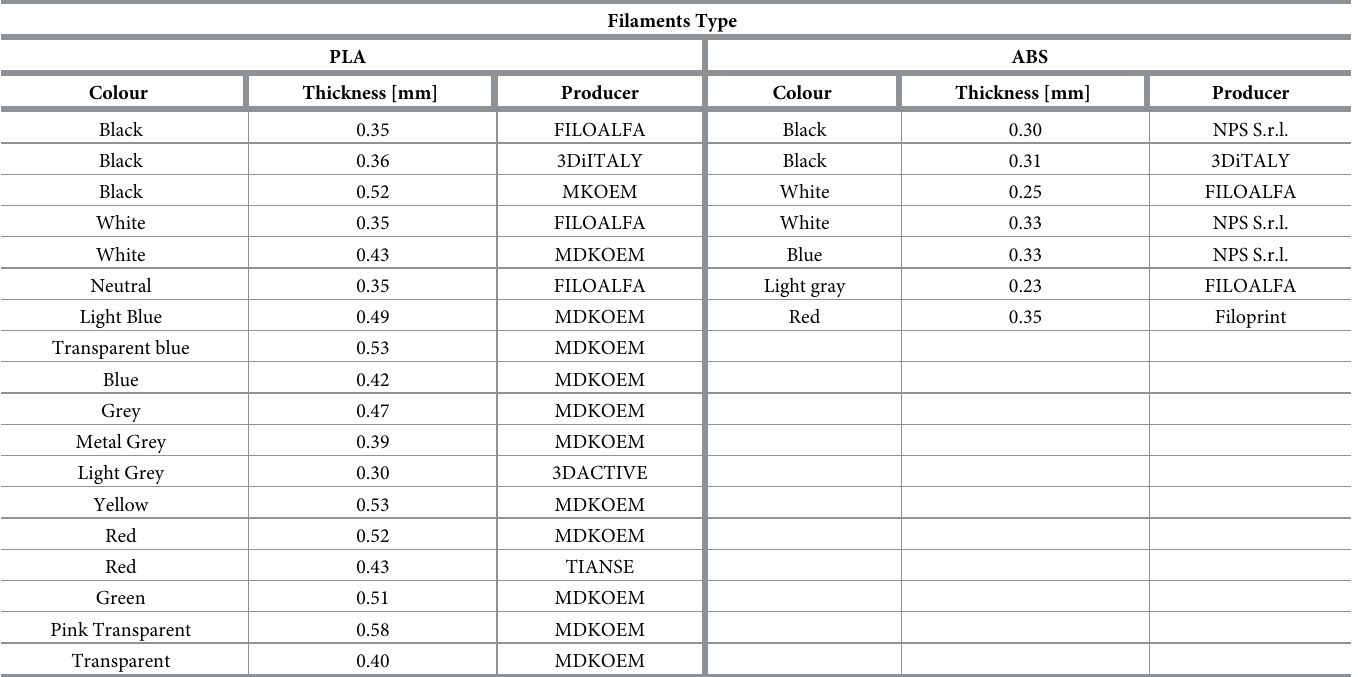
Table 1. Different kind of filaments employed for printing the sheets.